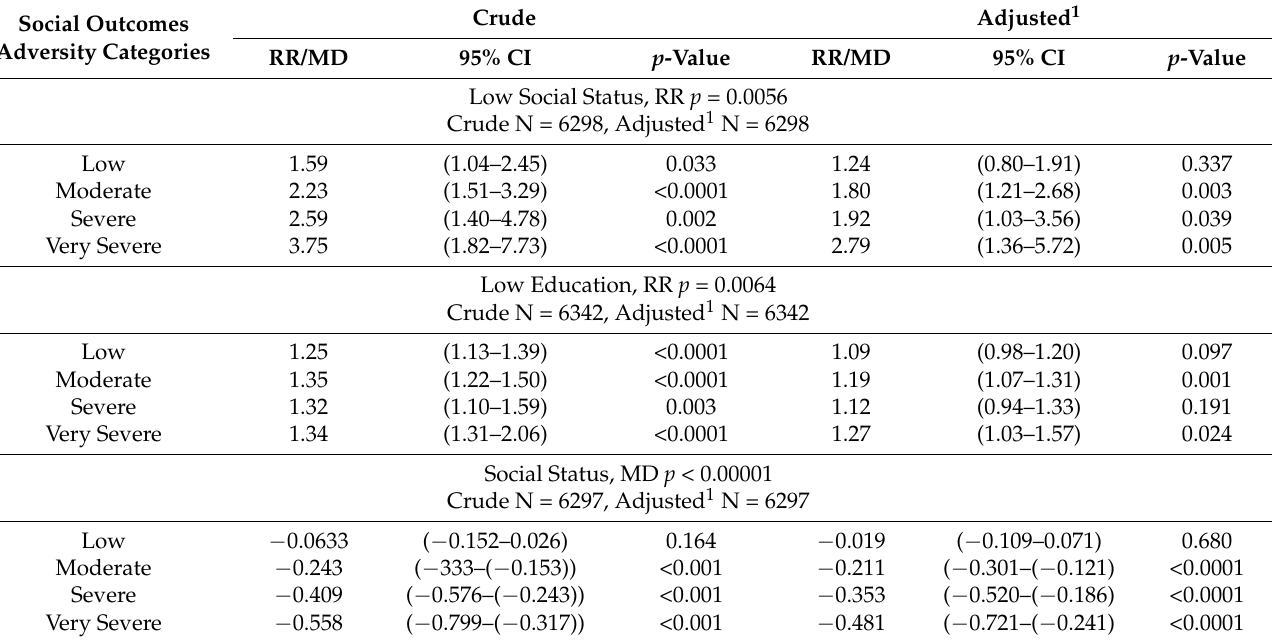
Table 8. Risk Ratio and Mean Differences between WICAC and social